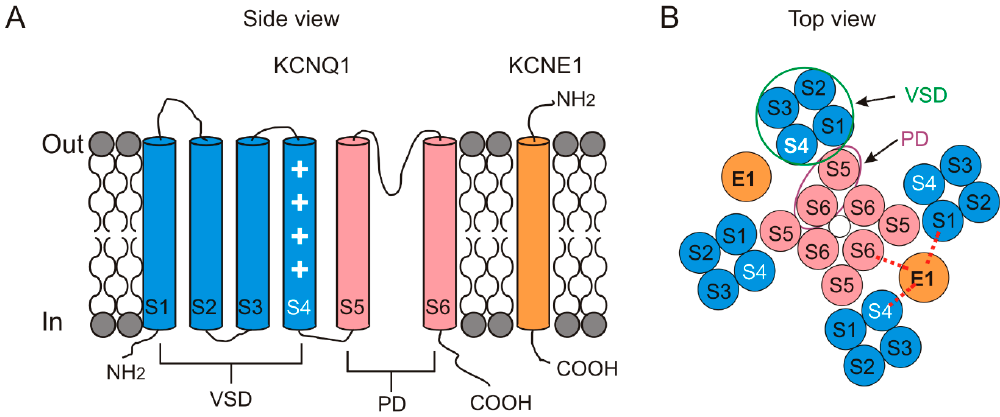
Figure 2. Topology of KCNQ1 and KCNE1. In the KCNQ1 subunit, S1–S4 transmembrane segments form the peripheral voltage-sensor domain (VSD) in blue and S5–S6 transmembrane segments form the central pore domain (PD) in pink. The KCNE1 subunit is one single transmembrane segment in orange. ( A ) Schematic side view of one KCNQ1 subunit and one KCNE1 subunit. The white plus symbol in S4 represents the positive gating charges. ( B ) Schematic top view of a tetrameric KCNQ1 channel with only two KCNE1 subunits. The number of the KCNE1 subunit varies from 1 to 4. KCNE1 is located in between S1, S4 and S6 from KCNQ1. Red dashed line indicates putative interactions between KCNE1 and S1, S4 and S6 from KCNQ1. A VSD (green circle) from one subunit is adjacent to a PD (purple oval) from its neighboring subunit.